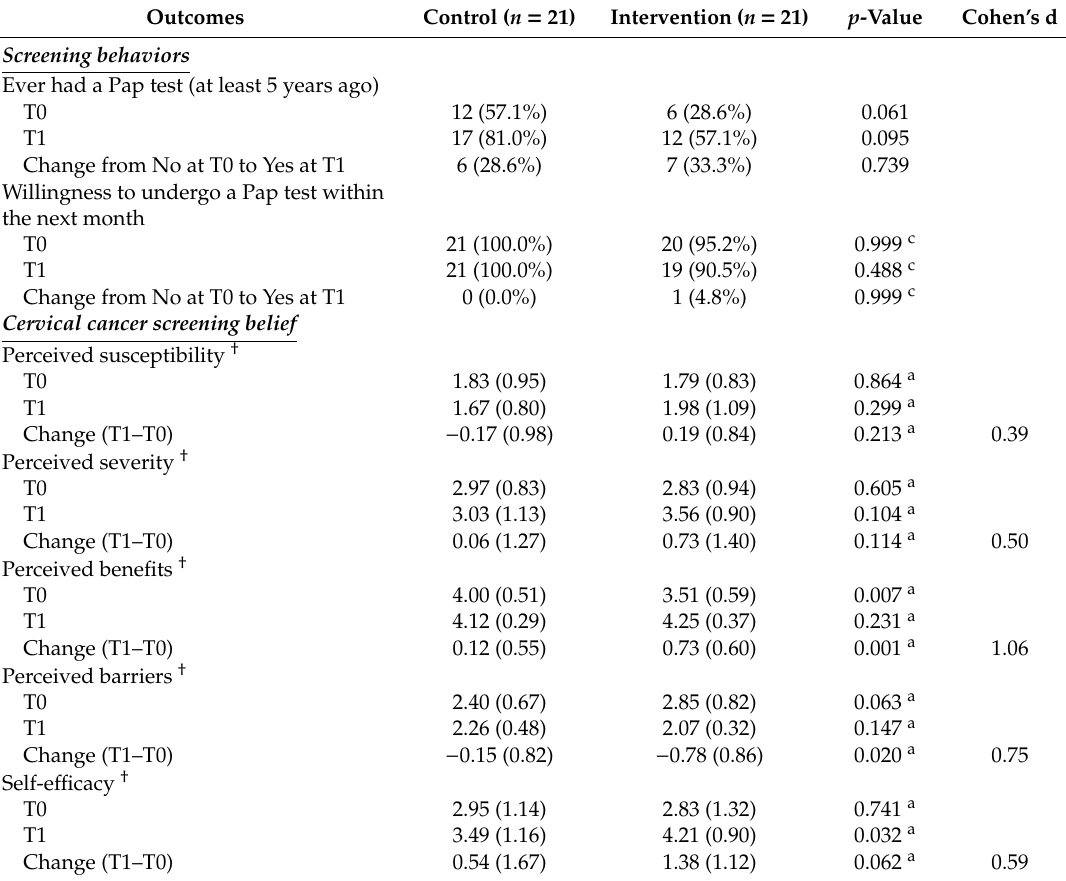
Table 3. Primary and secondary outcomes between control and intervention